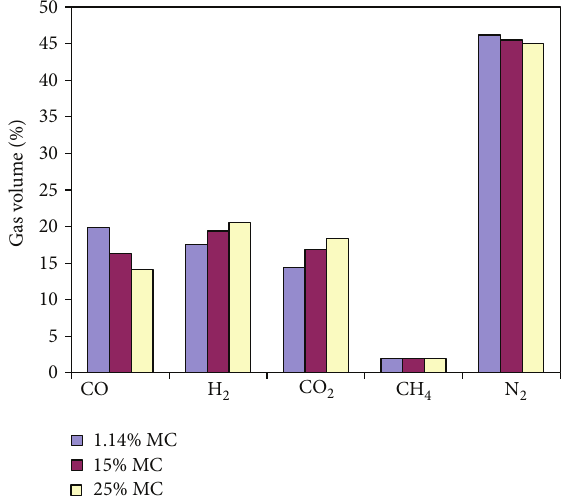
Figure 2: Gas volumes obtained through computer simulation.